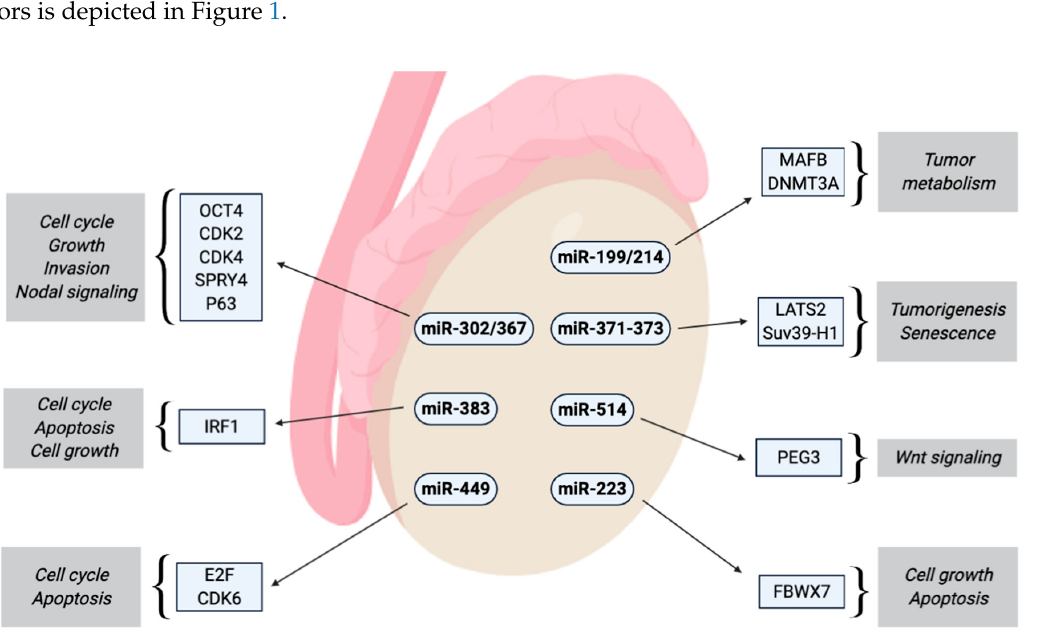
Figure 1. Summary of the effects of miRNAs with altered expression in TGCTs.